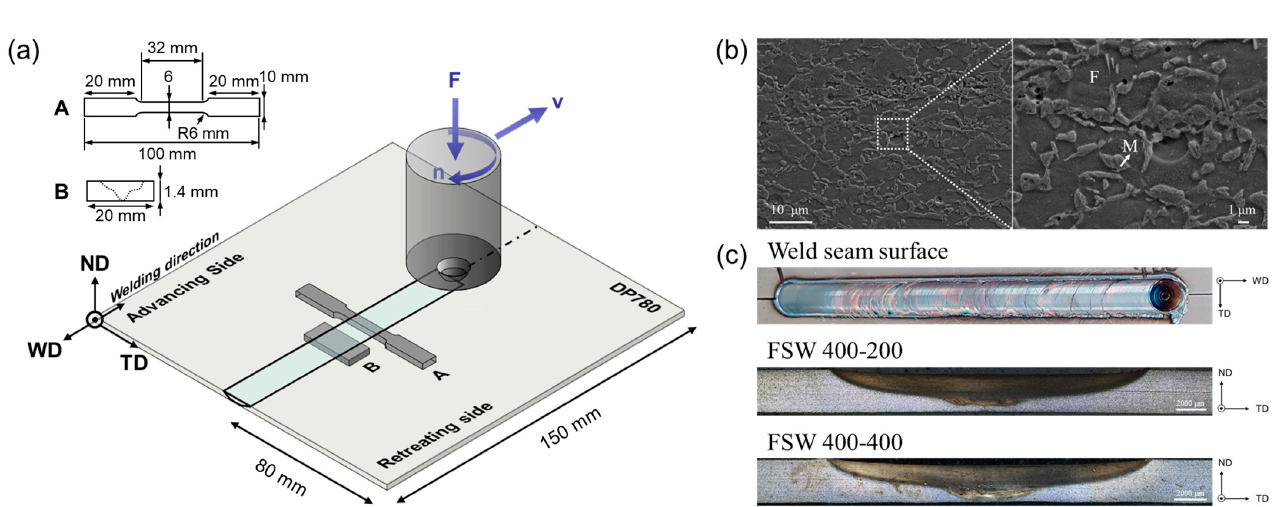
Figure 1. ( a ) The schematics showing the overall FSW process and the tensile sample configuration, ( b ) high and low magnification SEM micrographs of the BM, and ( c ) top and transverse view of FSW400-200 and FSW400-400 samples. Table 1. Chemical composition (wt.%) of DP780 steel.